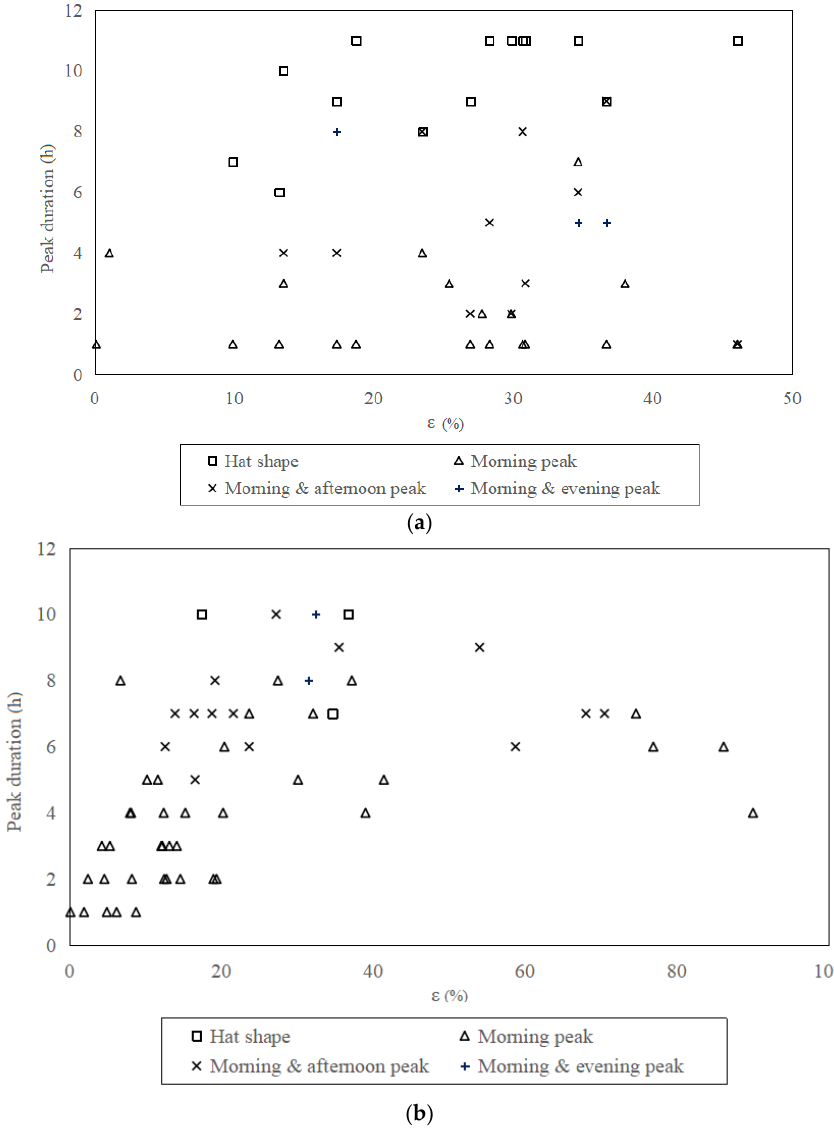
Figure 11. The distribution of peak types in winter and transition season. ( a ) The distribution in winter season. ( b ) The distribution in transition season.